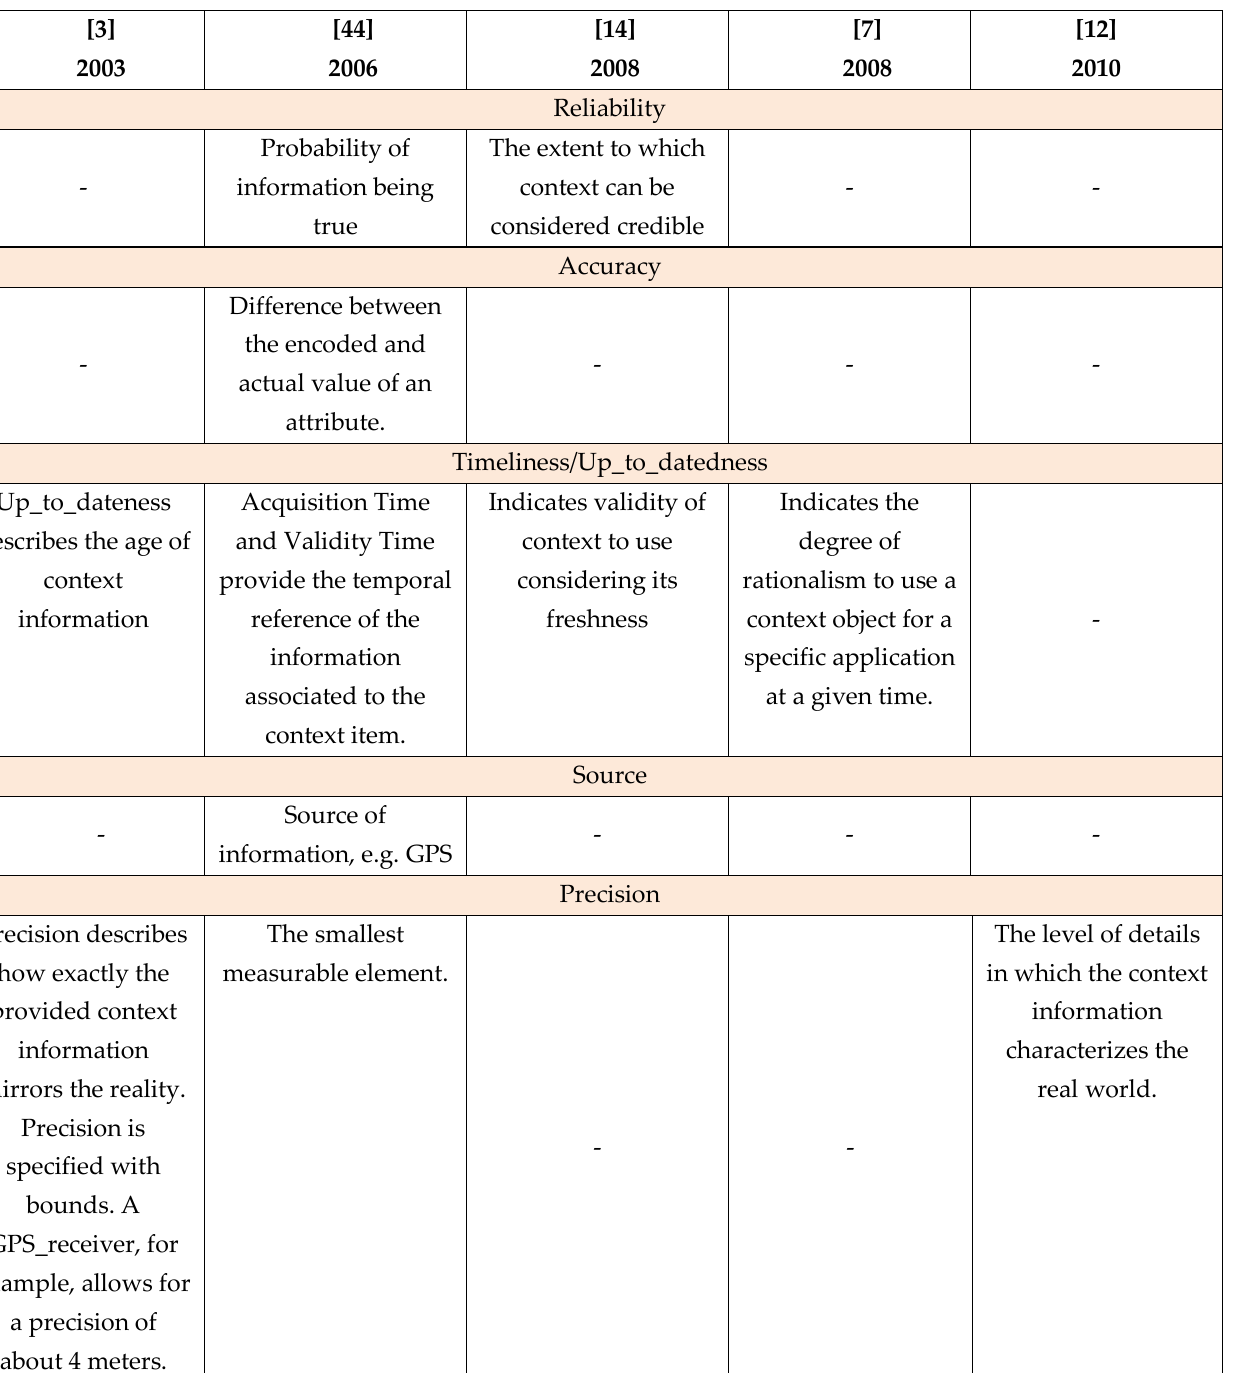
Table 1. Examples of QoC parameters in the